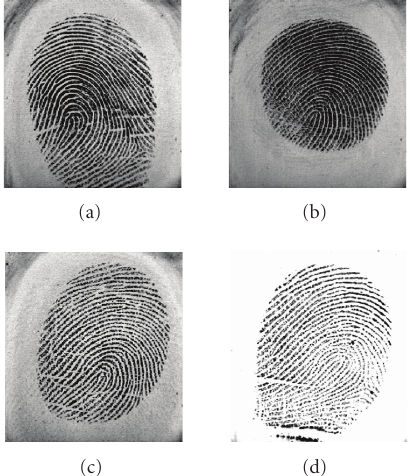
Figure 5: Test images with di ff erent visual quality from DB3: (a) Image 22 6, (b) Image 88 1, (c) Image 46 2, and (d) Image 24